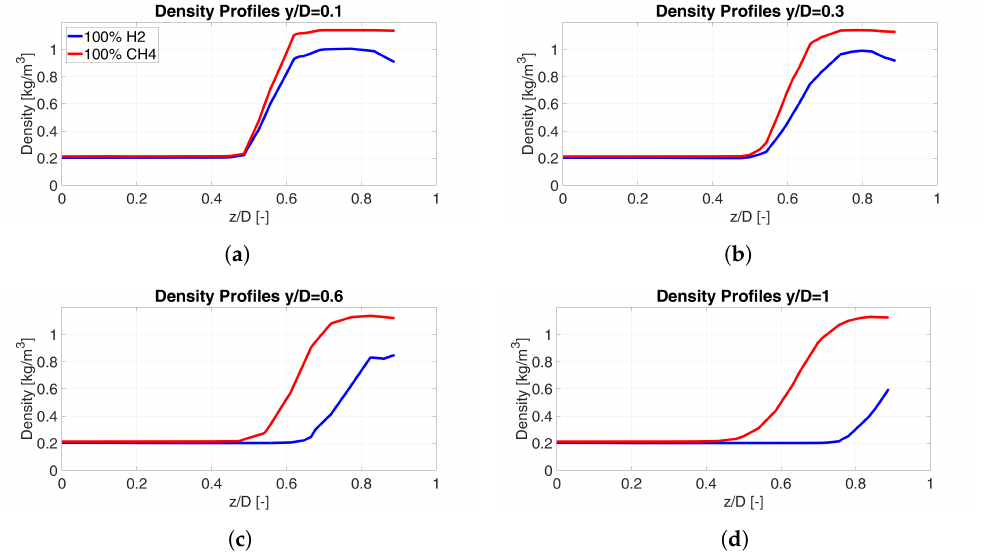
Figure 15. Comparison between the density profiles of the two different mixtures, at different axial positions (( a ) y / D = 0.1, ( b ) y / D = 0.3, ( c ) y / D = 0.6, ( d ) y / D =